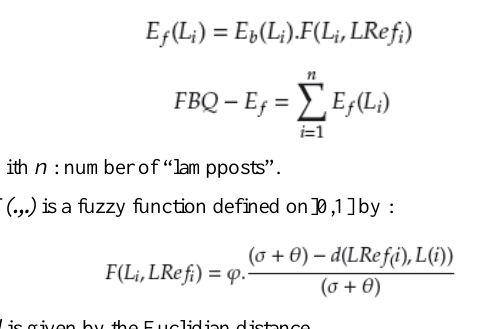
with σ φ .acc is not taken into account in our approach which is based on 2D reference map. The value of µ is given by σ θ . acc which is the vehicle vibration. 3.3.3 Fuzzy approach: E f (.) The fuzzy evaluation is based on the E f (.) metric